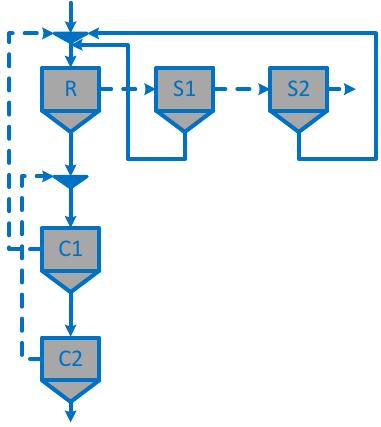
Figure 3. Structure obtained by maximizing the revenues.